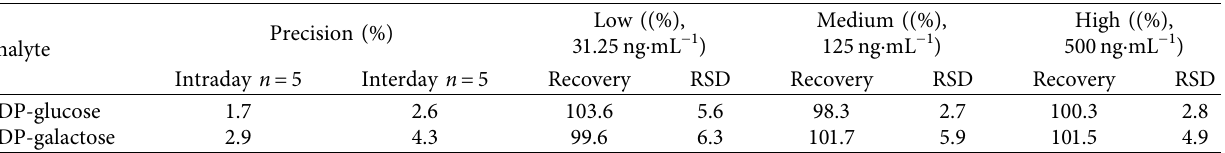
Table 3: Precisions and recoveries of UDP-galactose and UDP-glucose.